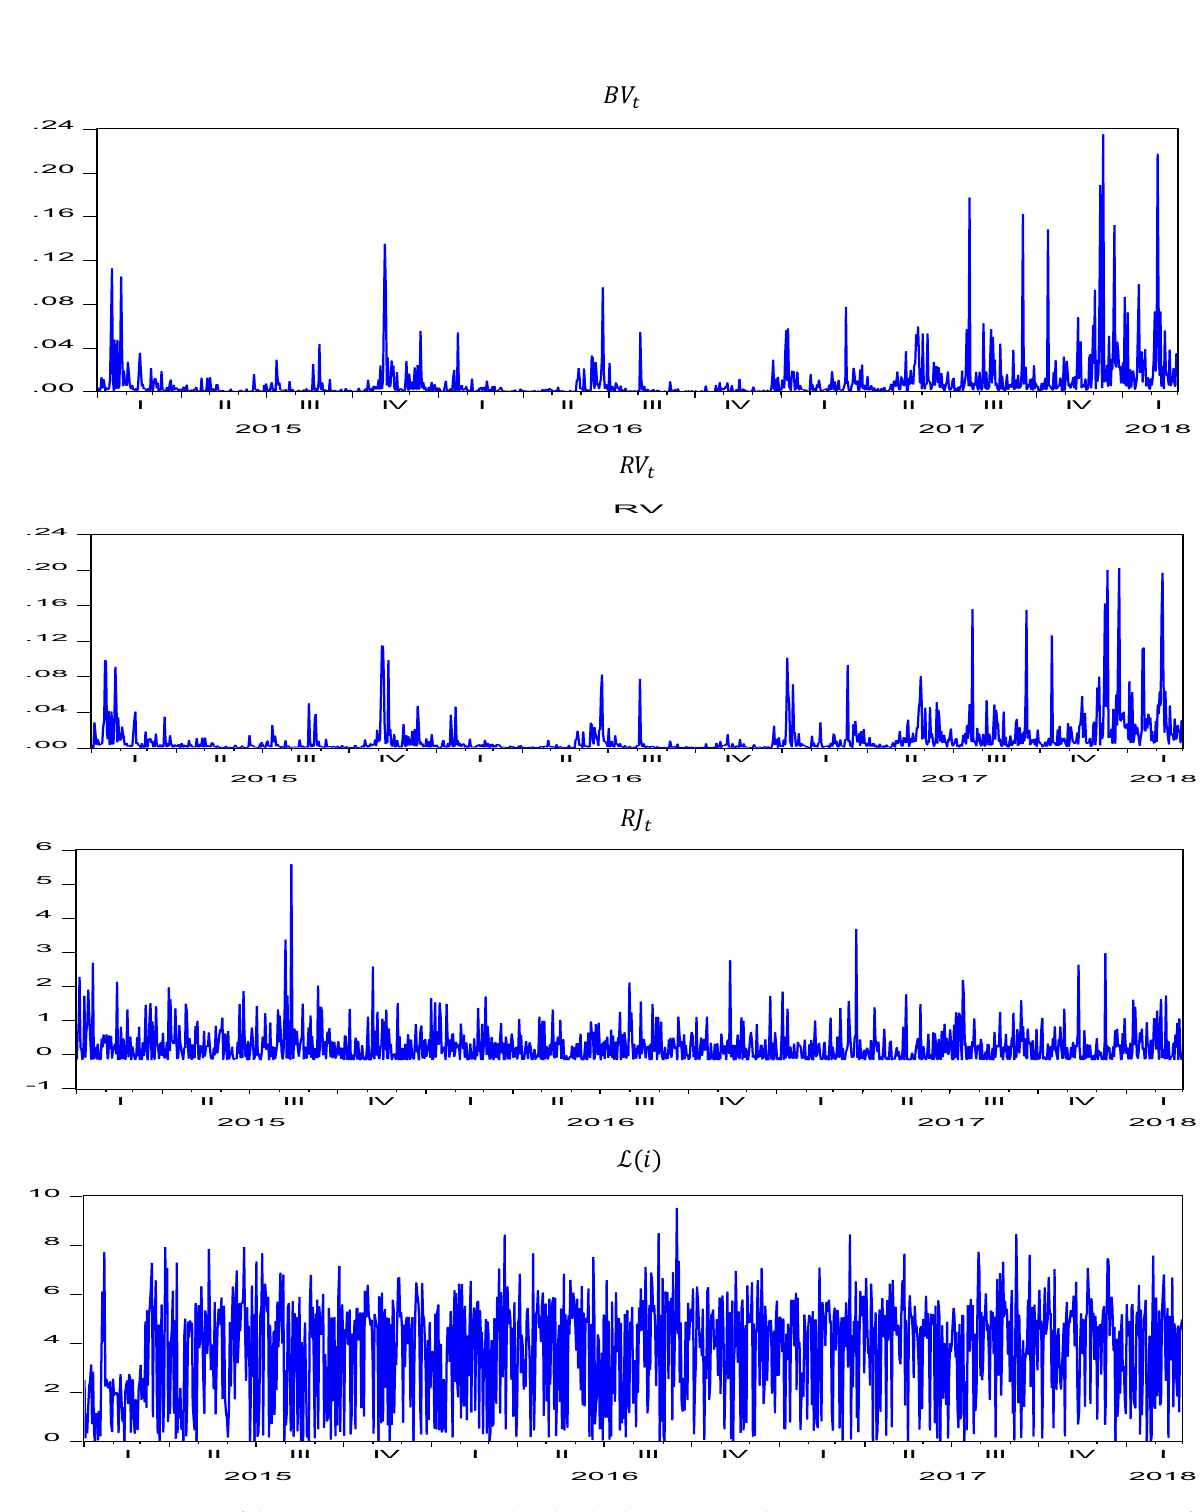
Figure 2. Return, Logarithmic Returns of Bitcoin. The top panel of the graph illustrates the daily returns of Bitcoin over the period time and the bottom panel of the graph illustrates the daily logarithmic returns of Bitcoin.